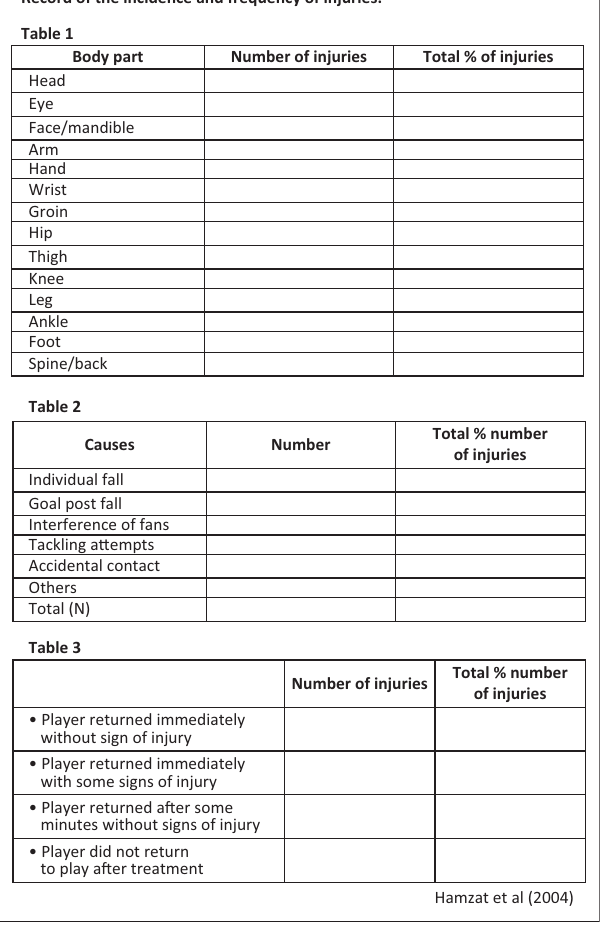
FIGURE 1-A1: Injury report form.